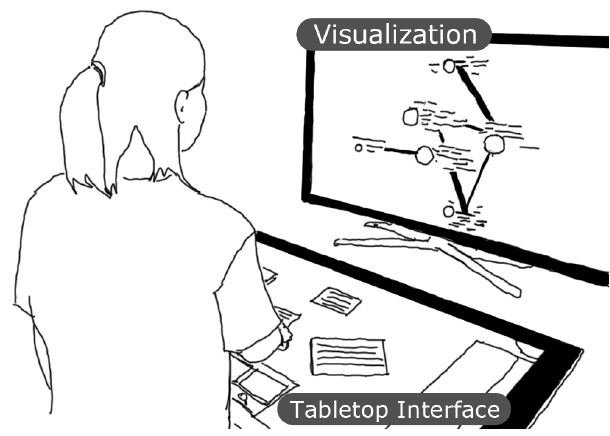
Figure 2. The BlogCloud system. The tabletop supports blog searching and viewing. The vertical display shows a visualization of the NLP-processed